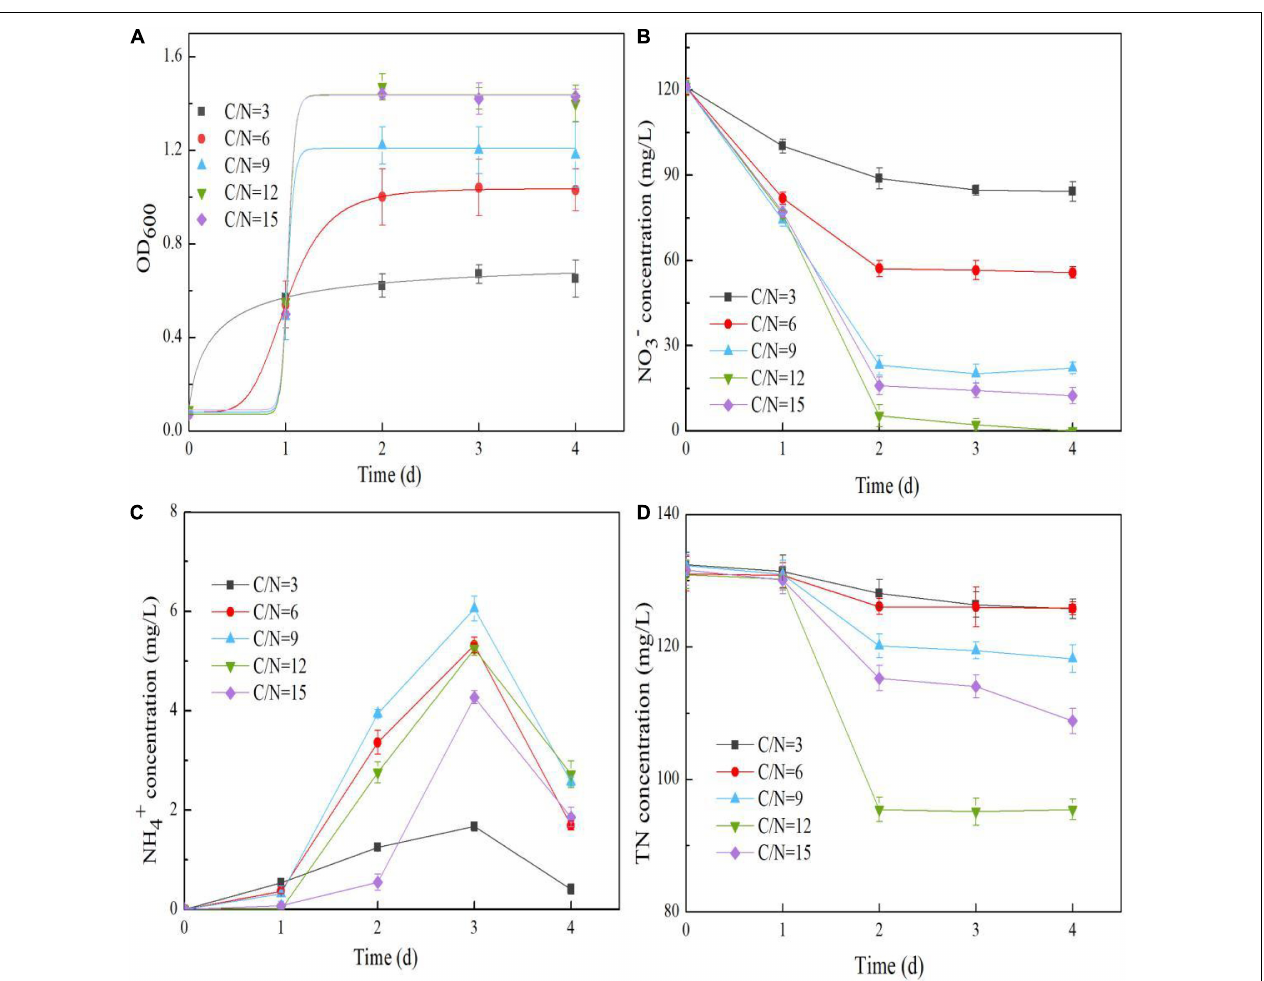
FIGURE 3 | Effects of the C/N ratio on the OD 600 (A) , NO 3 − concentration (B) , NH 4 + concentration (C) , and TN concentration (D) in the Pseudomonas putida Y-9 culture with glucose as the sole carbon source.